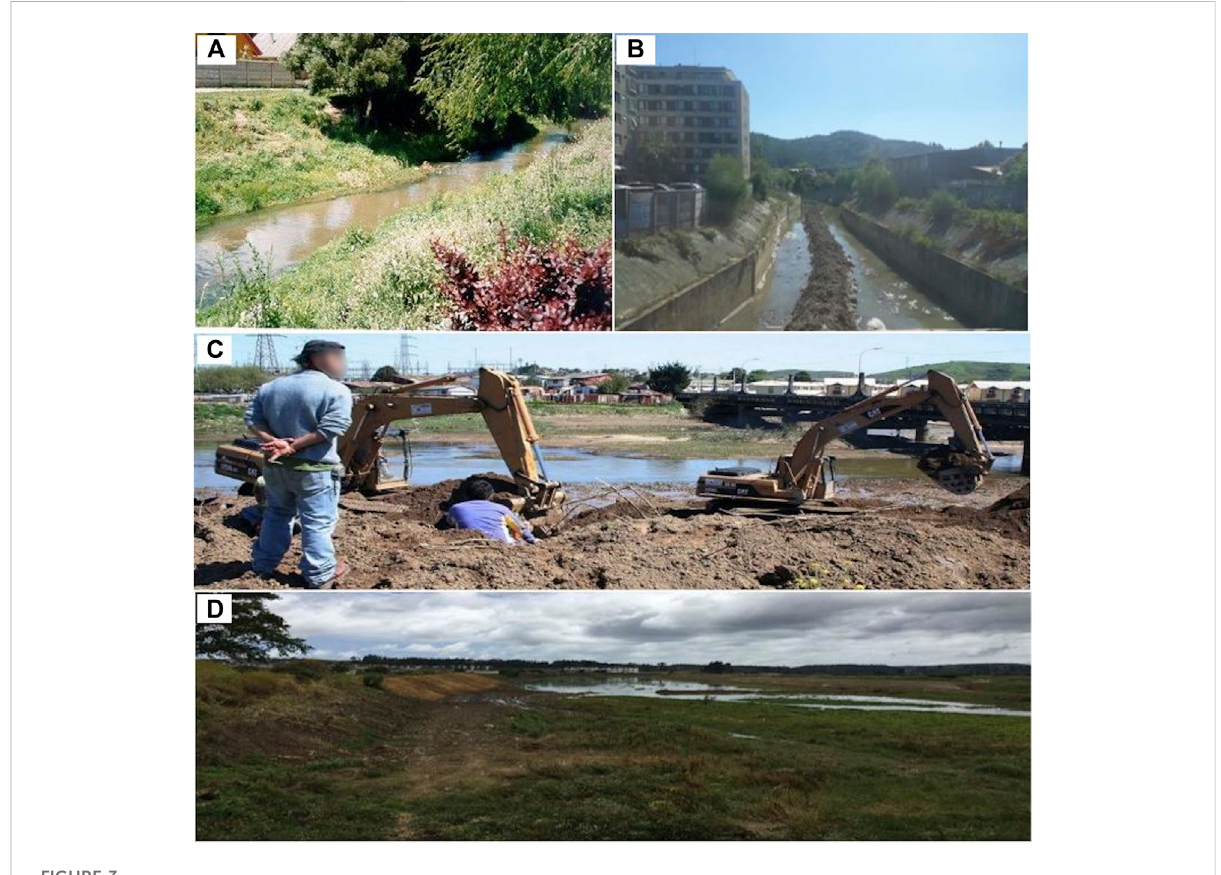
FIGURE 3 Potamon area of the Nonguén stream. (A) 2004, pre-channeling; (B) 2018, post-channeling, Potamon area of the Andalién River; (C) 2006 during dredging work in the riverbed; (D) 2018, post-widening and deepening of the